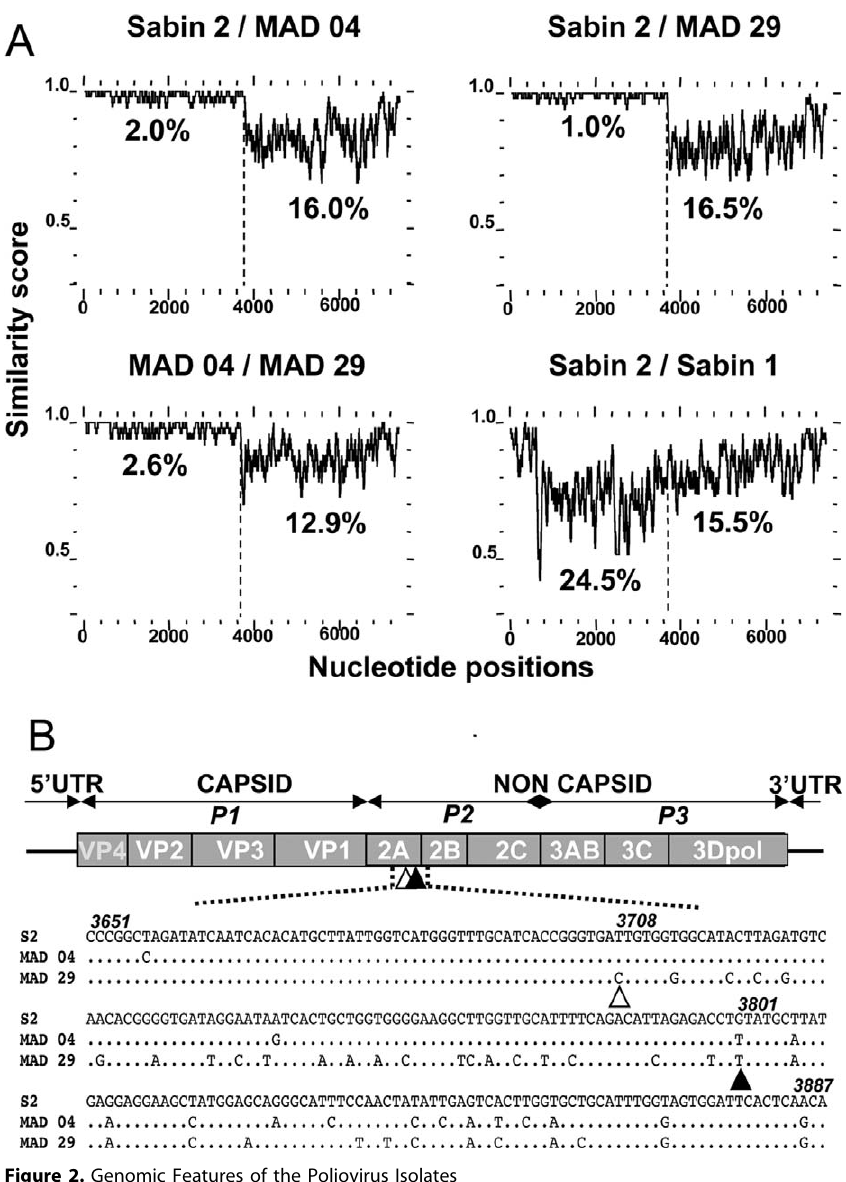
Figure 2. Genomic Features of the Poliovirus Isolates (A) Plots of similarity between a set of aligned genomes (Sabin 2, MAD 04, MAD 29, and Sabin 1), using a 50-nt sliding window. Approximate nucleotide positions in the poliovirus genome are indicated. Average nucleotide identities between the 5 9 vaccine part and the 3 9 non-vaccine part of the recombinant genomes are shown. (B) Sites of the recombination junctions in the recombinant VDPV genomes. The genetic organization of the PV genome is shown, including the 5 9 - and 3 9 -UTR. Genomic regions P1 to P3 encoding viral proteins (VP4 to 3Dpol) are indicated. Open and closed triangles indicate the approximate sites of the recombination junctions of the MAD 29 and MAD 04 recombinant genomes, respectively. Both junctions are located at the 3 9 end of the protease 2A genomic region. MAD 04 and MAD 29 sequences (nt 3651–3890) on both sides of the recombination junctions are given and compared with Sabin 2 sequences (S2). Nucleotide numbering according to Sabin 2 sequences is given in italics.